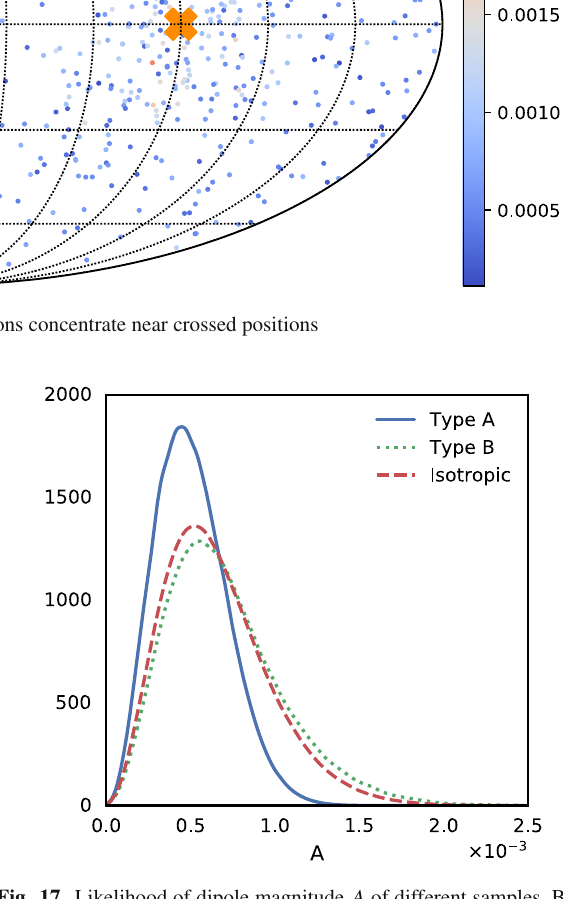
hemisphere comparison method are δ = 0 . 56 , l = 141 ◦ , b = − 11 ◦ . For JLA data set, fitted parameters are l = 94 . 4 ◦ , b = − 51 . 7 ◦ , A = 7 . 8 × 10 − 4 , B = 1 . 9 × 10 − 3 . The 1 σ error range of dipole direction covers almost the whole sky. The confidence level of dipolar anisotropy is merely 0.23%. Red- shift tomography results show slightly larger anisotropy at lower redshift